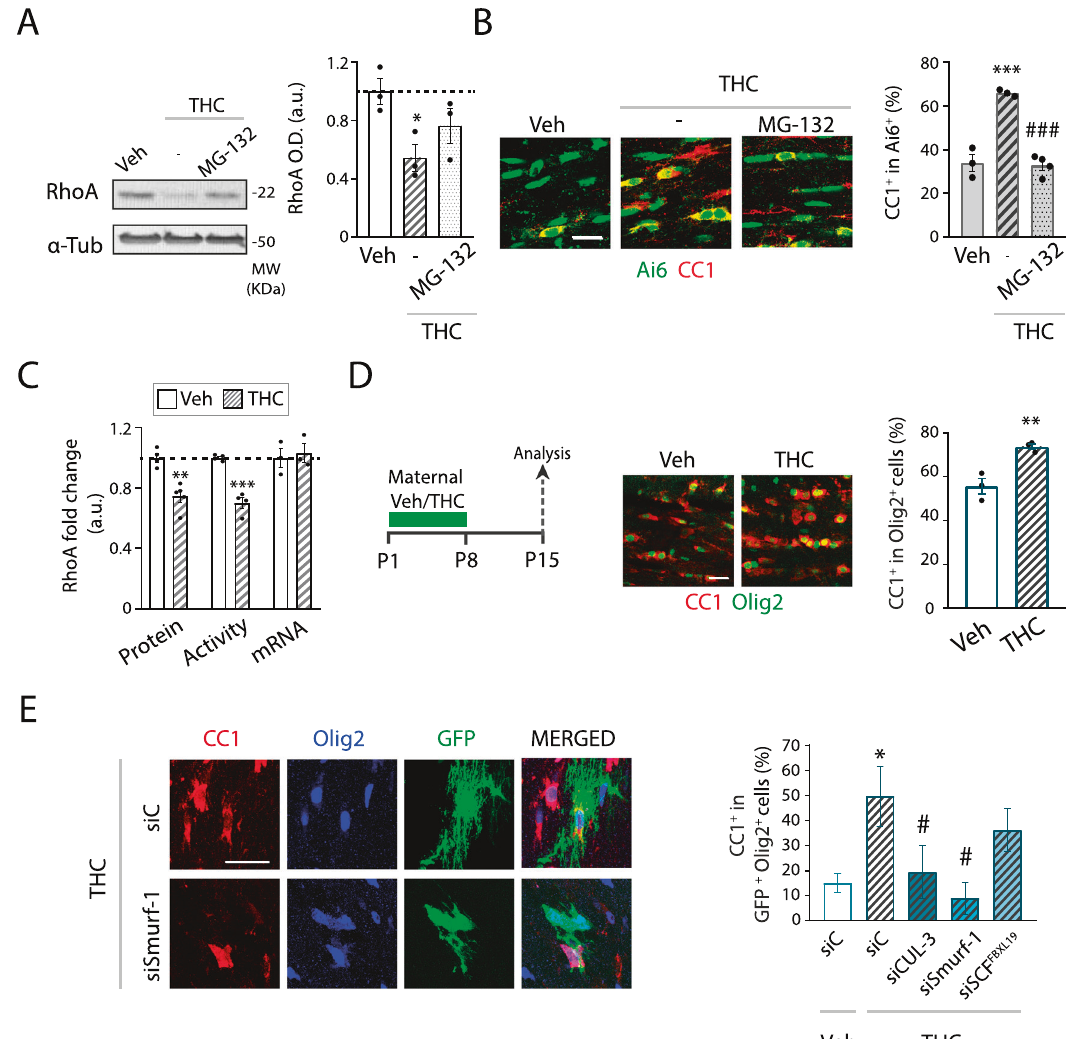
Fig. 5 CB 1 receptor modulates OPC differentiation through RhoA proteasomal degradation. A , B Ng2 /Ai6-CB 1 WT mice were administered with the proteasomal inhibitor MG-132 (5 mg/kg) at 30 min before THC. A Western blot analysis for RhoA in dissected CC extracts at 6 hours after THC. Quanti fi cation of optical density (O.D.). B Immuno fl uorescence analysis and quanti fi cation of the percentage of Ai6 + cells that expressed the OL marker CC1 at 48 hours after THC administrations. C Relative levels of RhoA protein levels, activity, or mRNA levels in CC extracts at 6 hours after THC. D Maternal Tetrahydrocannabinol (THC) administration induces oligodendrocyte development in postnatal pups. THC (3 mg/kg) or Veh were administered to CD1 mouse mothers the day their pups were 1 day old, once a day for 8 consecutive days, and oligodendrogenesis was analyzed in corpus callosum at postnatal days 15. Immuno fl uorescence analysis and quanti fi cation of the percentage of CC1 + OLs among the Olig2 + population. E Electroporation experiments with siRNAs against Cullin-3 (CUL-3), Smurf-1 or SCF FBXL19 , and with a GFP reporter plasmid control in Pups from Veh or THC-treated mothers. Quanti fi cation of CC1 + OLs among GFP + Olig2 + cells in the subcortical white matter at P30. Data are shown as mean ± SEM. n = 3 for A and D , n = 3 – 4 for B , n = 3 – 5 for C , and n = 4 – 9 for E , independent data points were used for each experimental group. * p ≤ 0.05, ** p ≤ 0.01 and *** p ≤ 0.001 vs vehicle-treated groups; # p < 0.05 and ### p < 0.001 vs THC-treated group, by one-way ANOVA followed by Tukey´s multiple comparisons for A and B , two-tailed unpaired Student ’ s t-test for C and D , and by one-way ANOVA Kruskal-Wallis followed by Dunn´s test for E . Scale bar, 20 µm for B, D , E